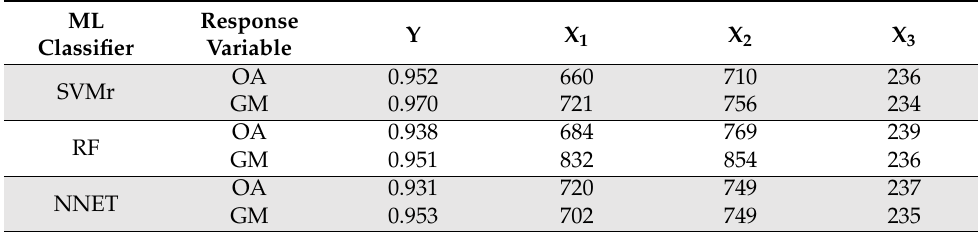
Table 6. Best condition for Overall Accuracy (OA) and G-Mean (GM) as a function of the number of tomato training sites (X 1 ), the number of other crop training sites (X 2 ), and the lead time (X 3